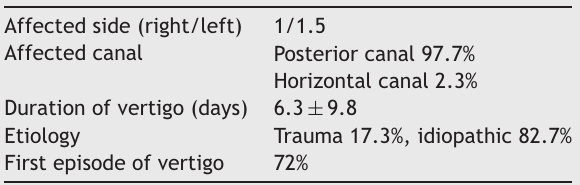
Clinical and demographic characteristics of patients with